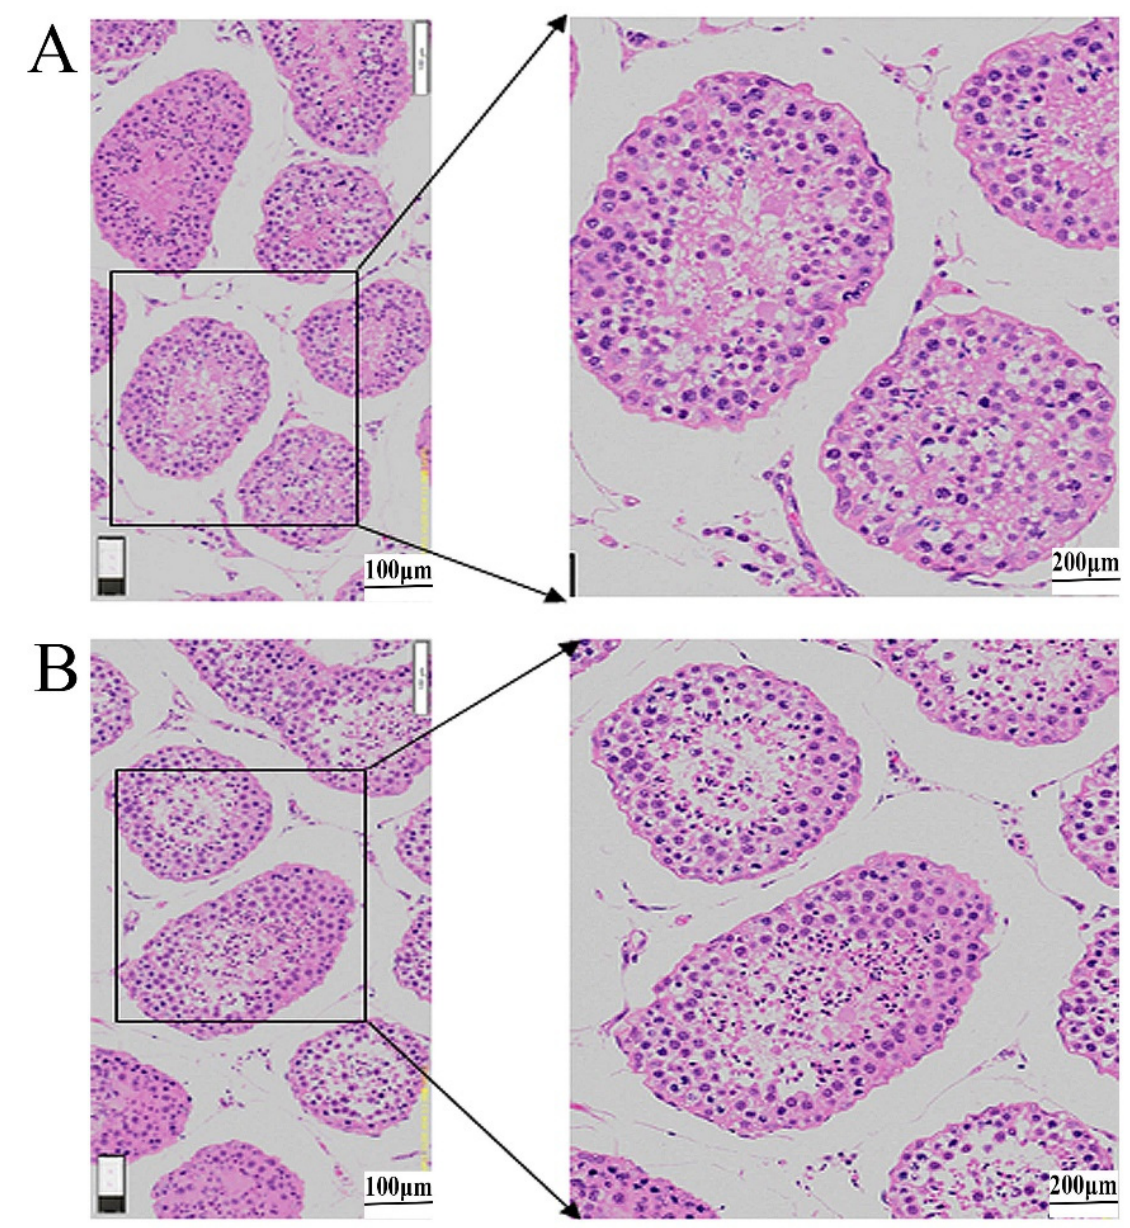
Figure 2. EGFP lentivirus does not affect the morphology of testicular tissue and spermatogenesis. ( A ) Testis pre-EGFP: Testicular tissue morphology at different microscope magnifications before EGF lentivirus injection. ( B ) Testis after EGFP: Testicular tissue morphology at different microscope magnifications after EGFP lentivirus injection ( n = 3).